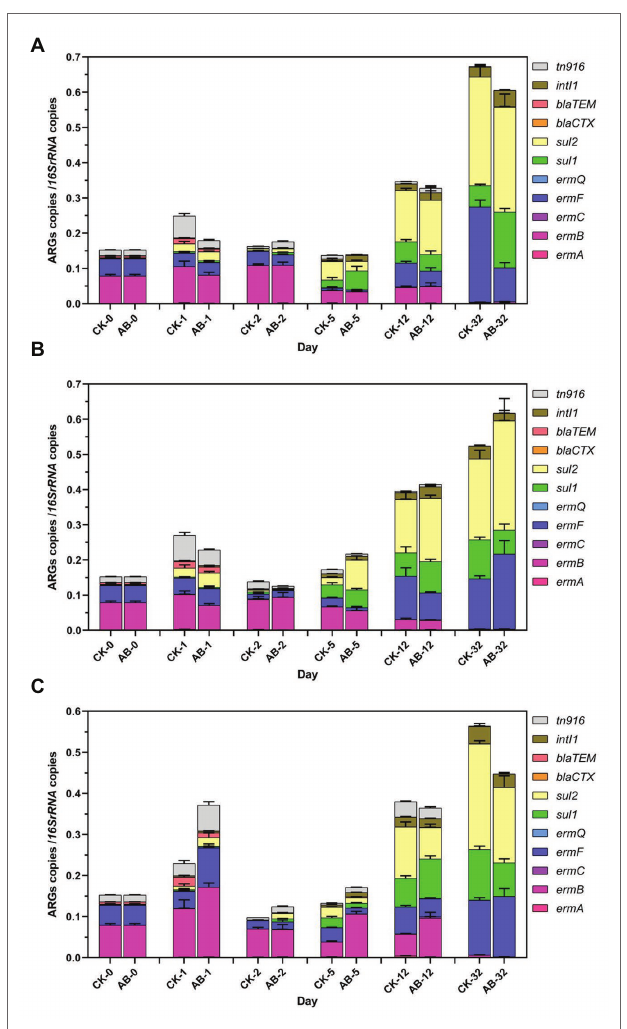
FIGURE 3 | Abundances of ARGs and MGEs during swine manure composting. (A–C) refer to the upper, middle, and lower layers of compost, respectively. CK: the swine manure composting. AB: add 1% compound microbial agents in the swine manure composting. 0, 1, 2, 5, 12, and 32 are the days for